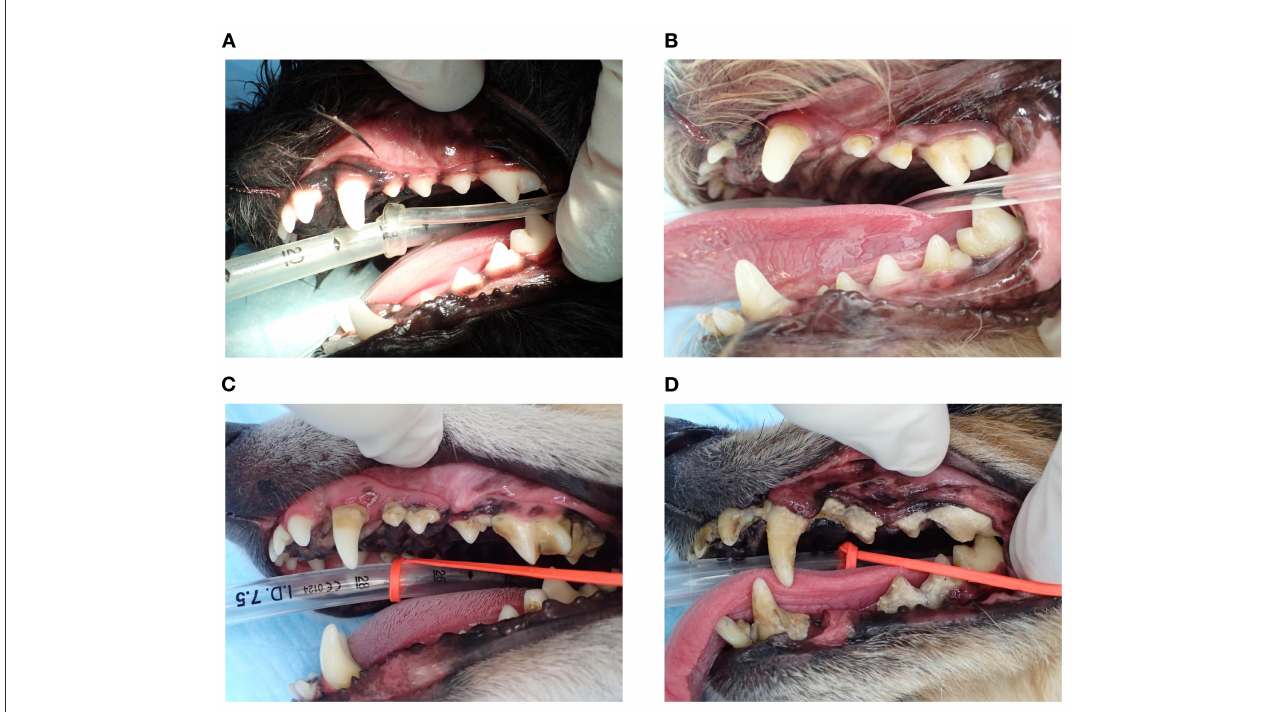
FIGURE2 Representative image of gingival and teeth of dogs in the 50–100-months age group. (A) A subject negative for Porphyromonas gulae , (B) fimA -type A P. gulae , (C) fimA type B P. gulae , and (D) fimA type C P. gulae